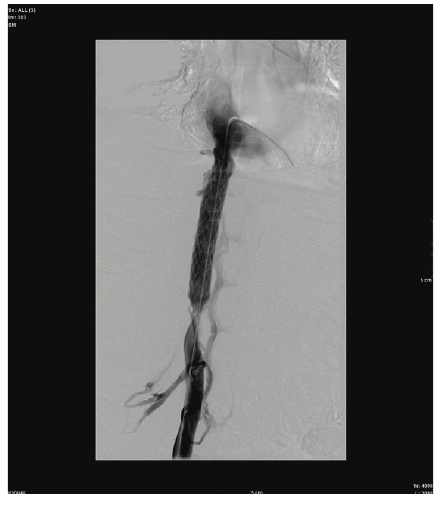
overlapping Palmaz stents. The gradient across the stenosis measured 12 mm Hg. The following day, a third 4010 Palmaz stent was mounted on a 16 mm diameter angioplasty bal- loon and deployed. Completion angiography demonstrated excellent angiographic result; however, the gradient remained 12 mm Hg (Figure 4). torsion (Figure